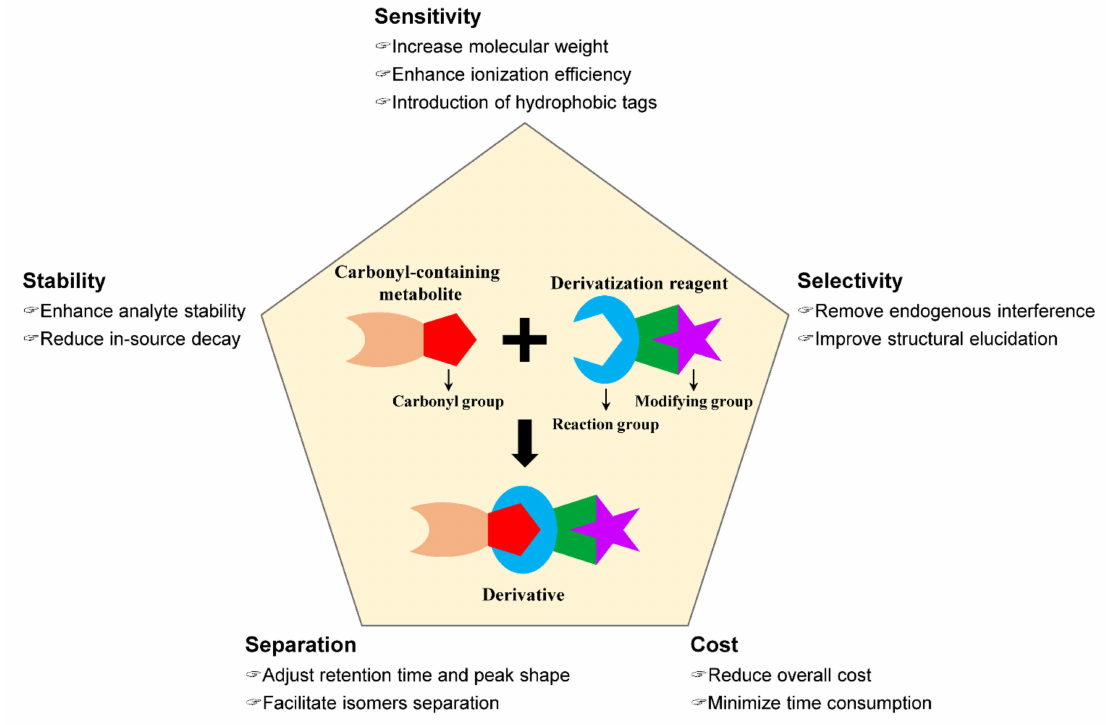
Figure 1. Key factors of an excellent chemical derivatization